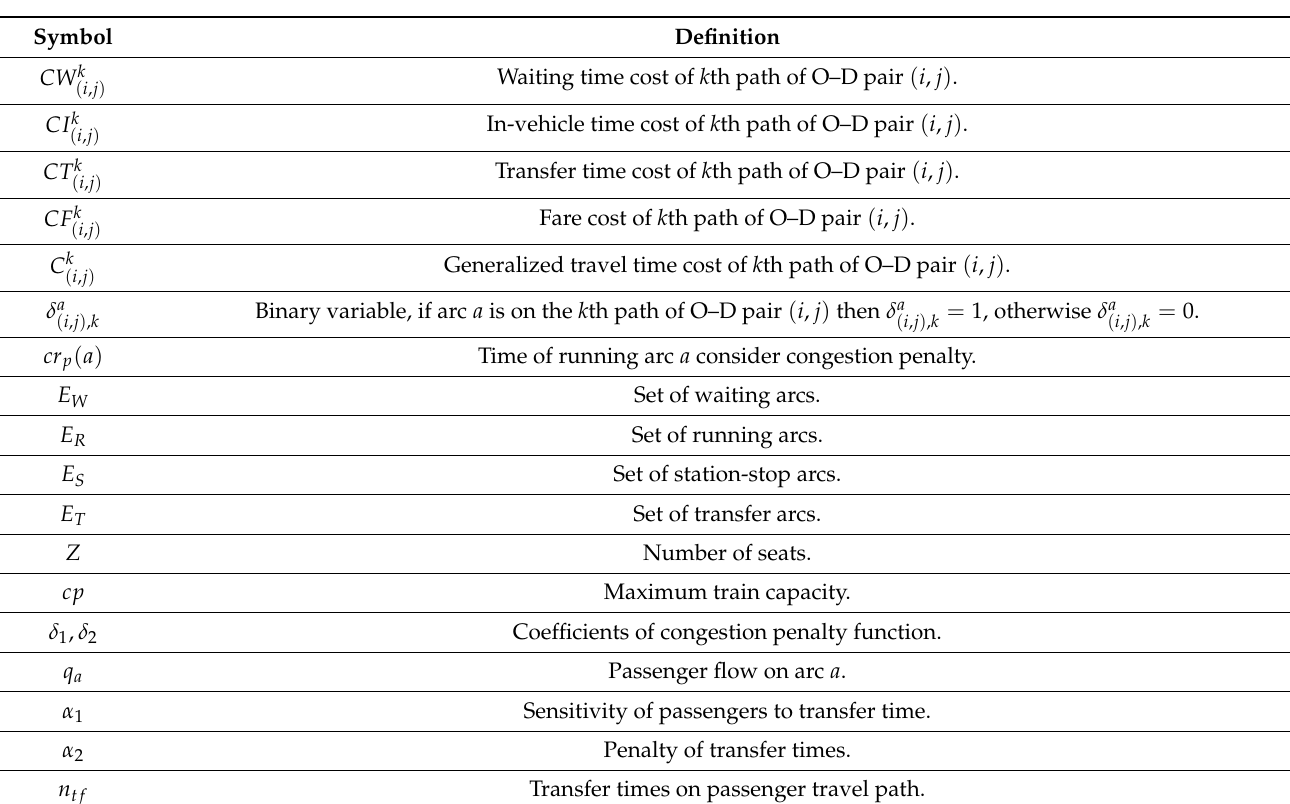
Table 2. Passenger generalized travel cost related